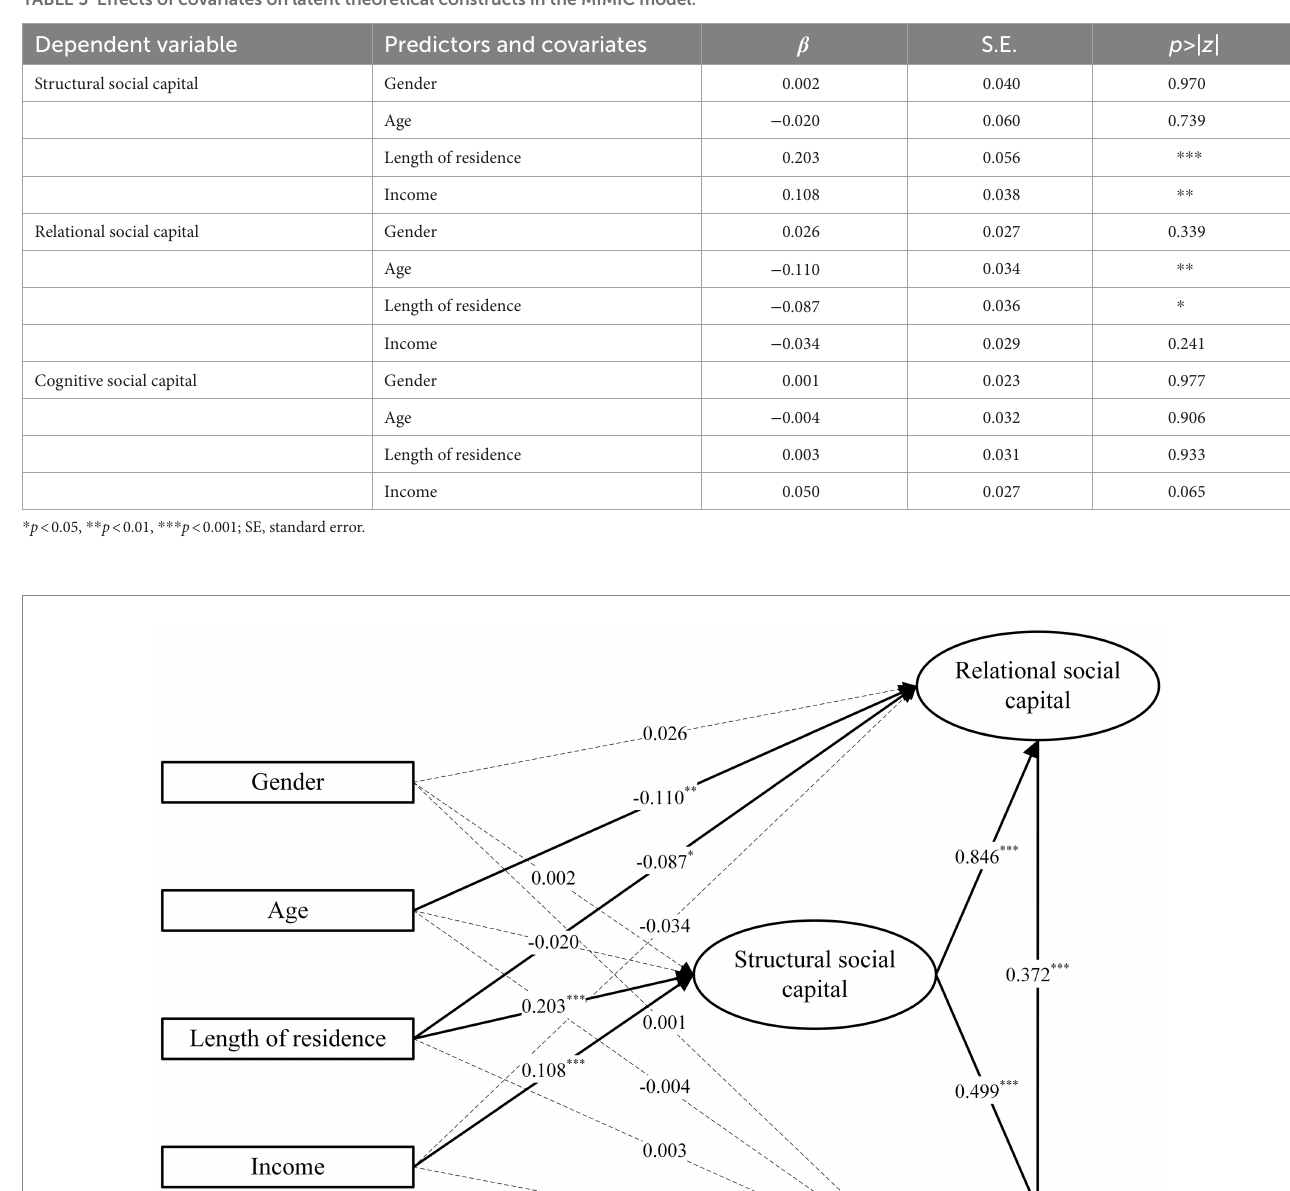
TABLE 5 Effects of covariates on latent theoretical constructs in the MIMIC model.